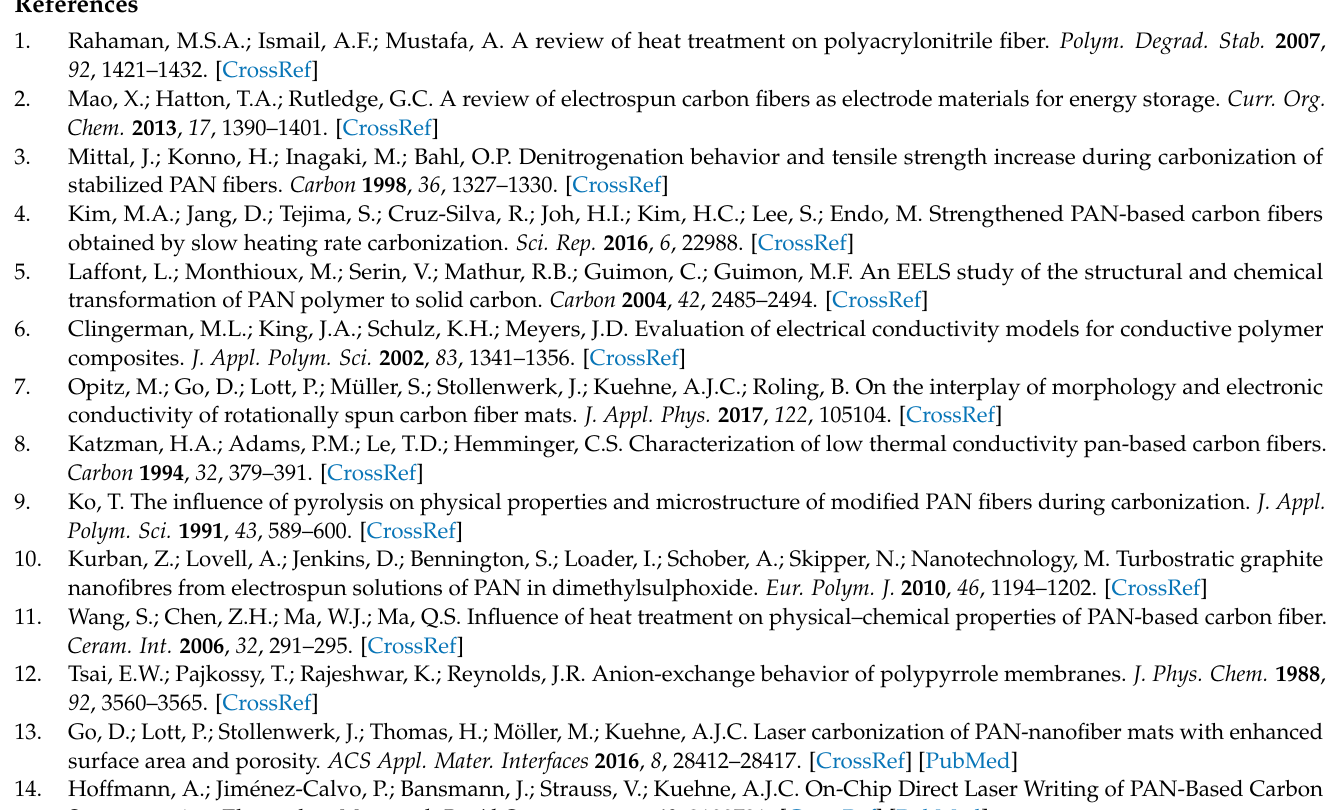
bonized nonwoven and plasma-jet carbonized nonwoven; Figure S4: Galvanostatic charge/discharge curves of plasma-jet carbonized nonwoven; Scheme S1: Cell-setup for electrochemical measurements; Table S1: Fitting parameters of the equivalent circuit fit in the of the Nyquist plots in Figure 4a. for various plasma-jet exposure times; Table S2: Atomic ratios of plasma jet carbonized samples, extracted from XPS-measurements; Table S3: Ratio of deconvoluted peak-areas in Figure